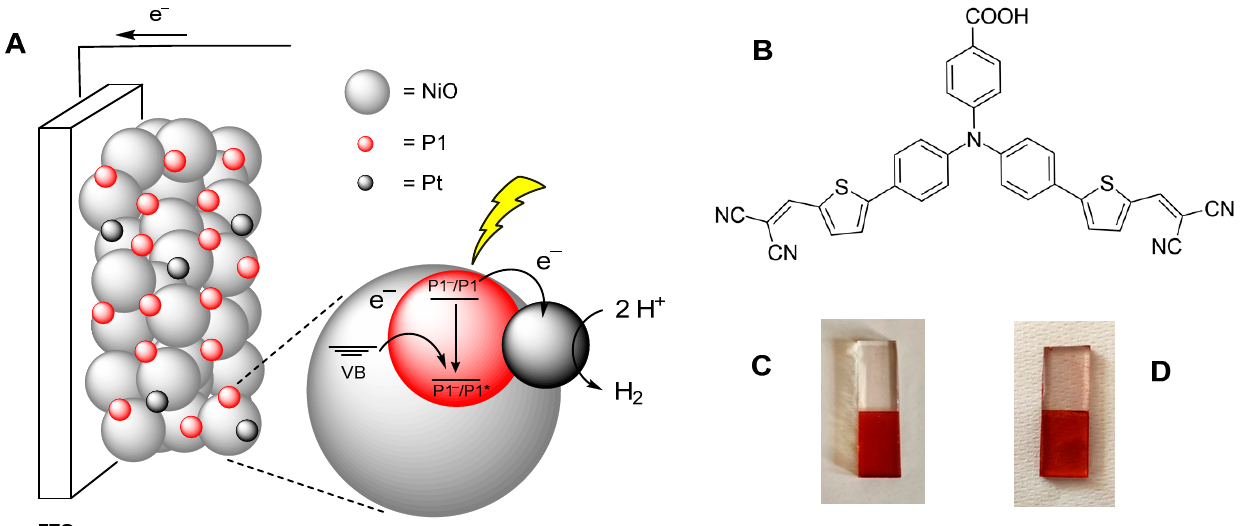
Figure 1. ( A ) Pictorial representation of the NiO photocathode and the related mechanistic pathways towards hydrogen evolution; ( B ) molecular structure of the P1 dye; pictures of a sensitized NiO electrode of ( C ) type A and ( D ) type B.